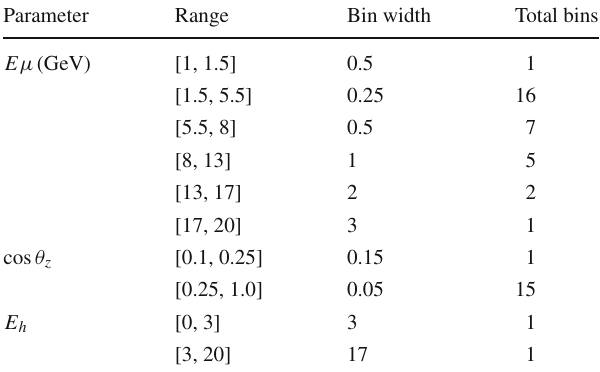
Fig. 5 a Without oscillated event distribution. b Oscillated event distributions Table 2 The binning scheme adopted for the reconstructed parameters E μ and cos θ z for muons induced due to down-going neutrinos, where χ 2 is estimated considering only muon events Parameter